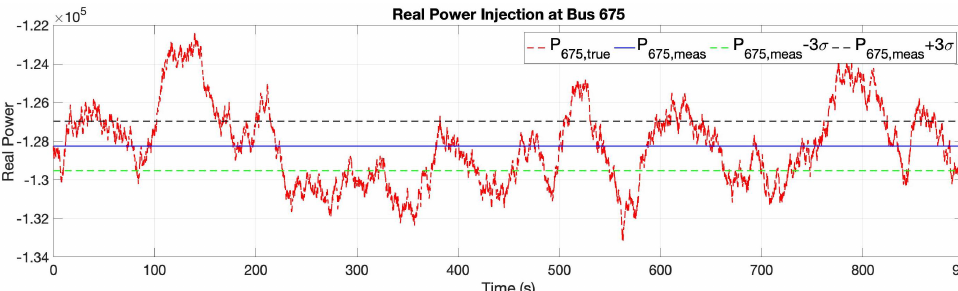
Figure 2. Unsynchronized measurement taken at t = 0 s and the load-induced drift of its true value over